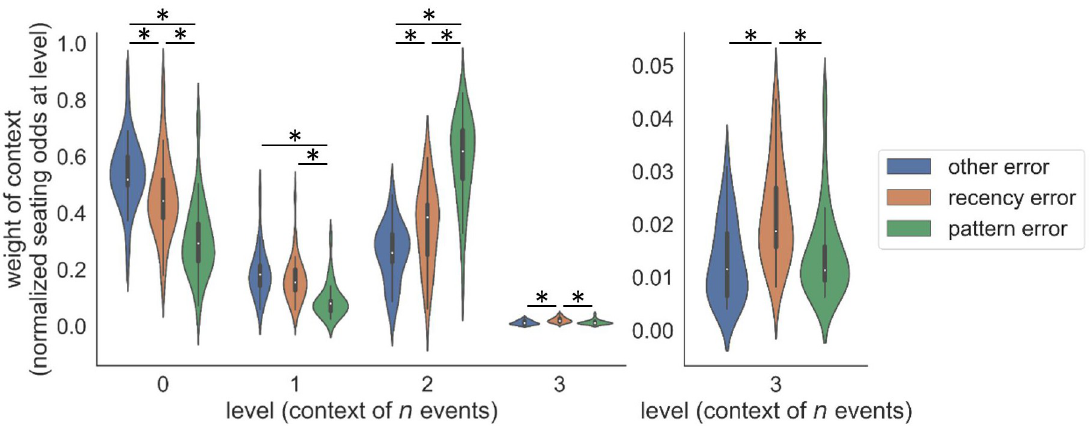
Fig 10. The HCRP f weighting of context depth is different among errors of different types. (Left) Weights of all HCRP f levels. (Right) Zoomed in for HCRP f level 3